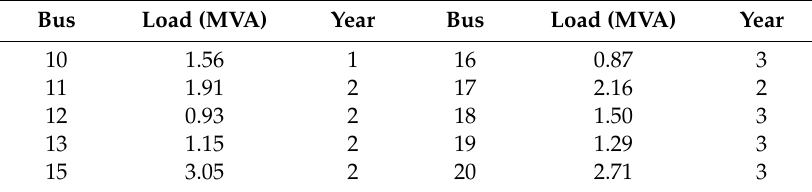
Figure 5. 24-bus distribution network. Table 1. Future load